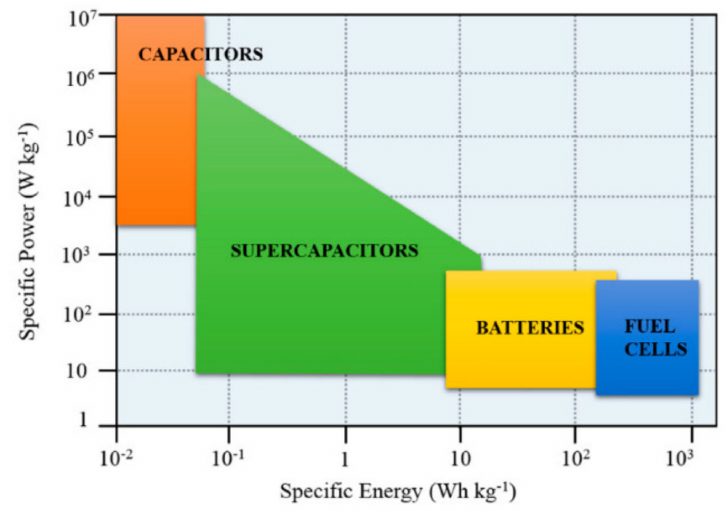
Figure 2. Ragone plots for different types of electrochemical energy storage devices. Adapted from [7]. Copyright (2019) MDPI. This article is an open access article distributed under the terms and conditions of the Creative Commons Attribution (CC BY)